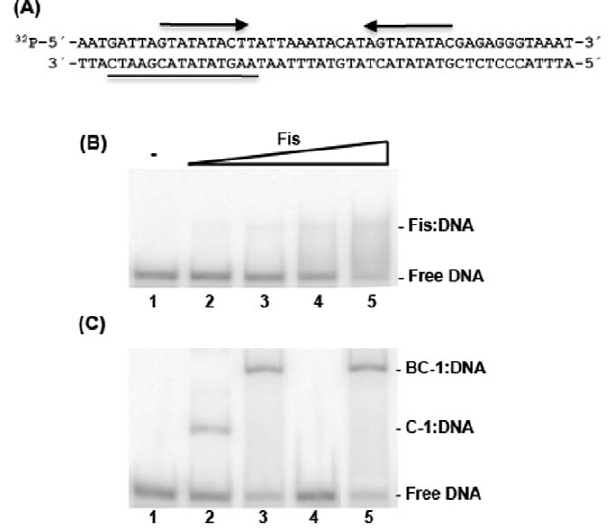
Figure 4. Fis, VapC-1 and VapBC-1 bind the vapB-1 TIR. (A) The sequence of the 50TIR indicating the putative Fis binding site ( underline ) and the inverted repeat regions ( arrows ). (B) Gel shift products from samples containing 50TIR alone ( lane 1 ) and 10, 30, 150 or 600 molar ratios of Fis to DNA. (C) Products from samples containing 50TIR alone ( lane 1 ), VapC-1 ( lane 2 ), VapC-1 followed by VapB-1 ( lane 3 ), VapB-1 ( lane 4 ), or the reconstituted VapBC-1 complex ( lane 5 ). VapB-1 and VapC-1 are present in a 150:1 molar ratio to 50TIR. In VapBC-1 samples, VapB-1 and VapC-1 are at a 3:1 molar ratio, with a VapC-1:DNA molar ratio of 150:1. This ratio is reported since VapC-1 is the DNA binding protein and the actual amount of VapBC-1 complexes cannot be determined. The identity of each band is noted at the right of each gel. Each gel represents one of two independent experiments.